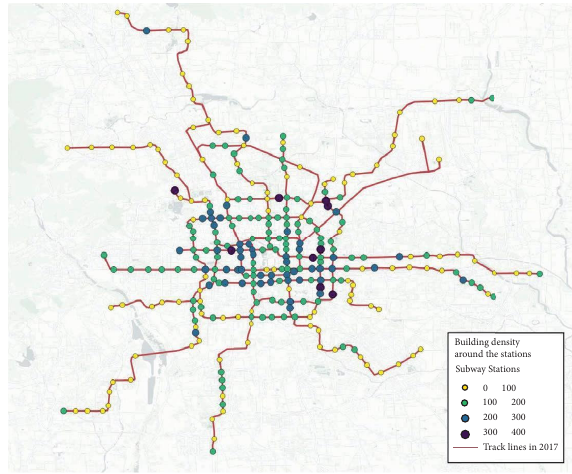
Figure 11: Building density around the